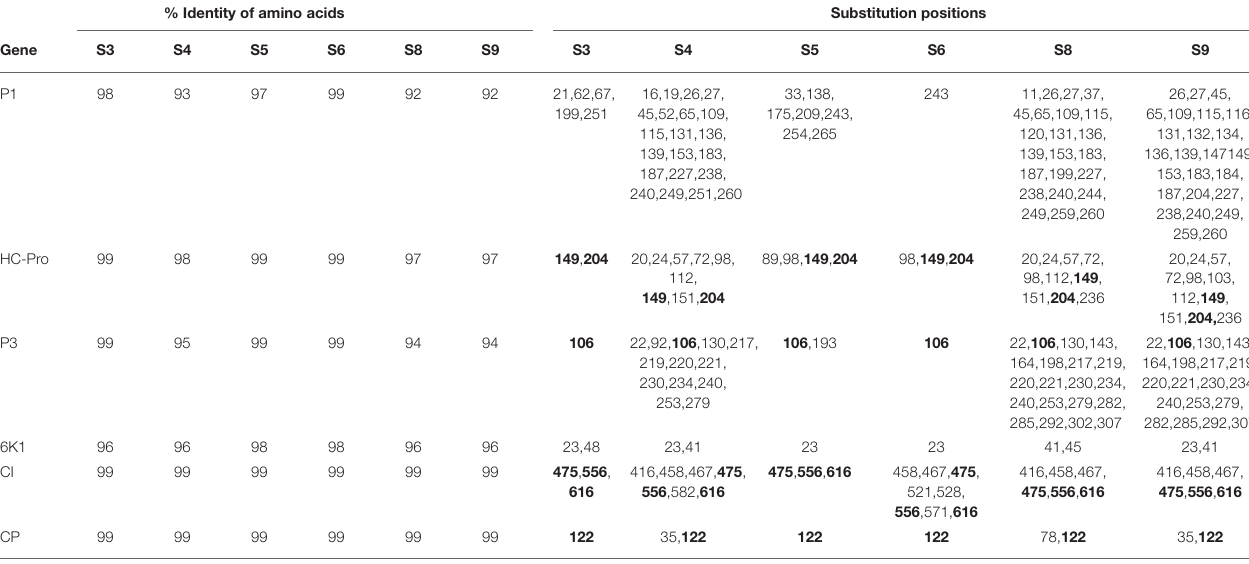
TABLE 4 | Summary of amino acid sequence comparisons between BCMNV strain TN1 and (S3, S4, S5, S6, S8, S9). % Identity of amino acids Substitution positions